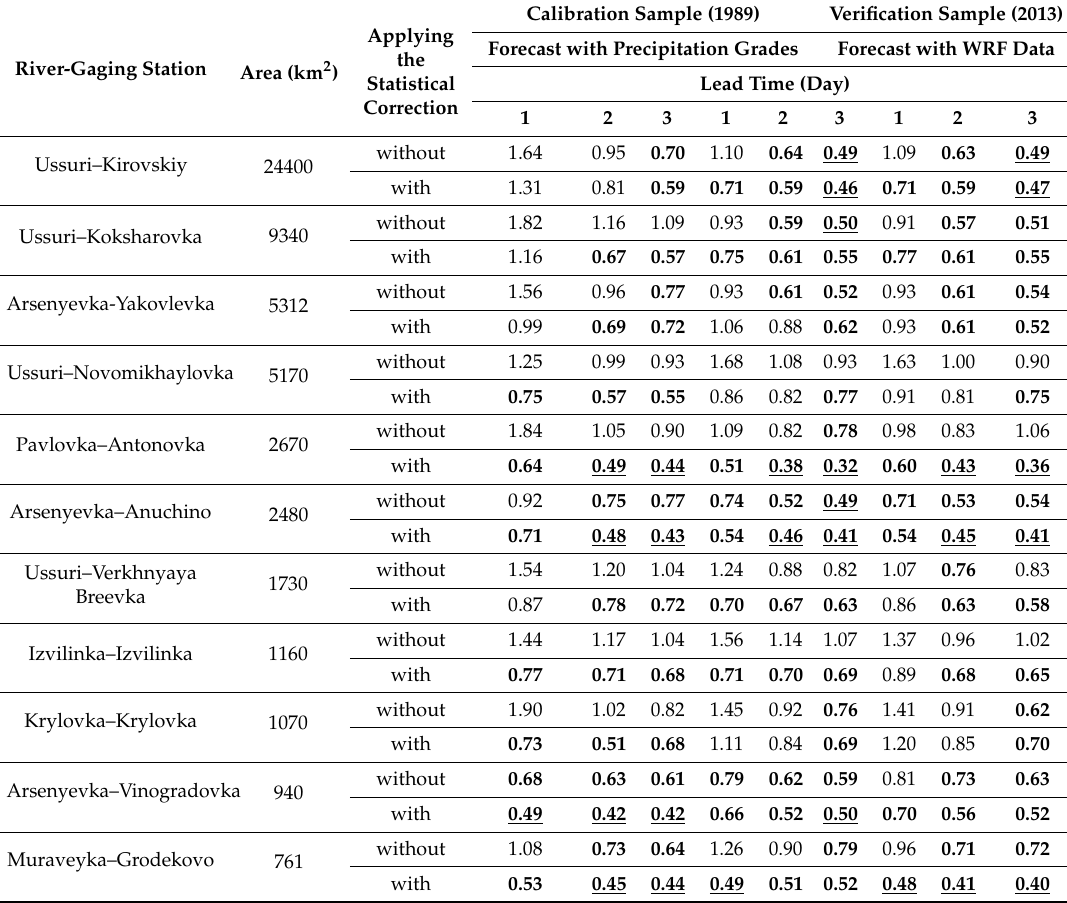
Table 1. Estimates of the quality of short-term forecasts of flow S / σ ∆ in forecasting points *.